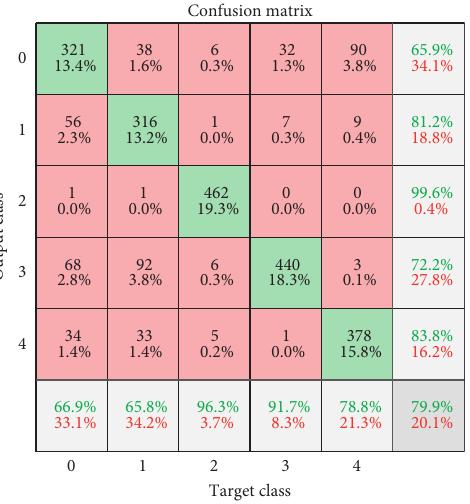
Figure 9: Confusion matrix for CNN-M.